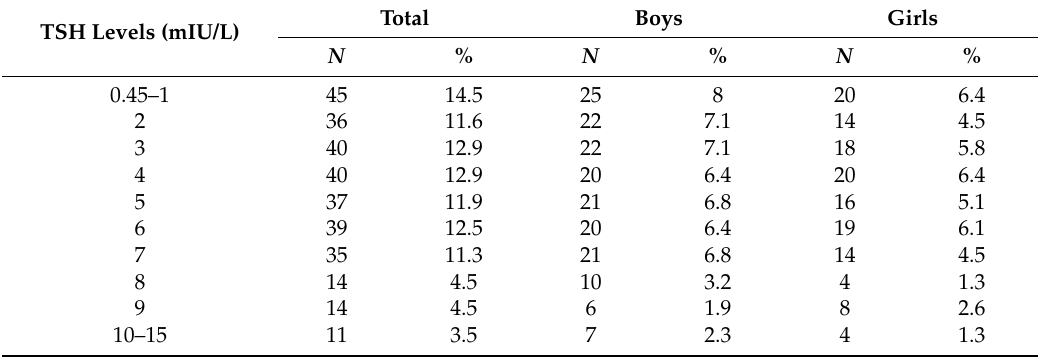
Table 1. Descriptive and demographics characteristics of the study population according to gender. PsychoTSH study, Belgium,